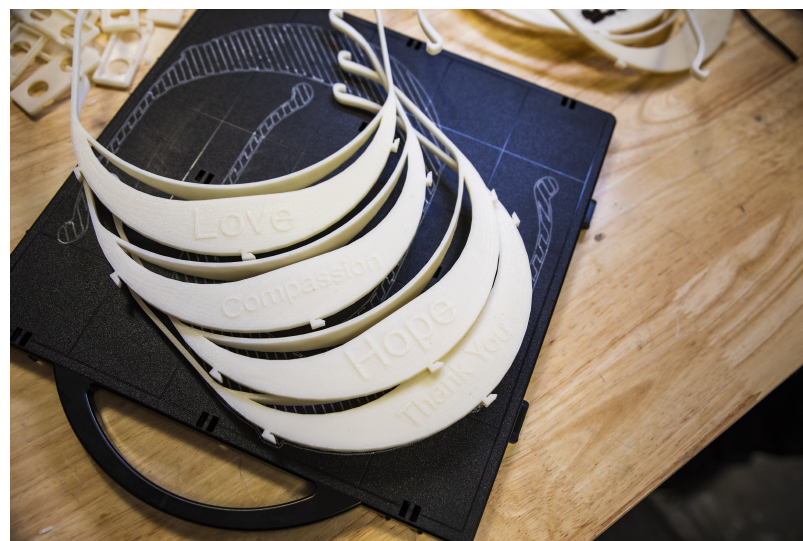
Figure 1. 3D printed face shield visor manufactured in out laboratory to support national coalition efforts. Design: Stratasys’ three hole punch spacing visor. Machine: Fortus 250 mc. Material: acrylonitrile butadiene